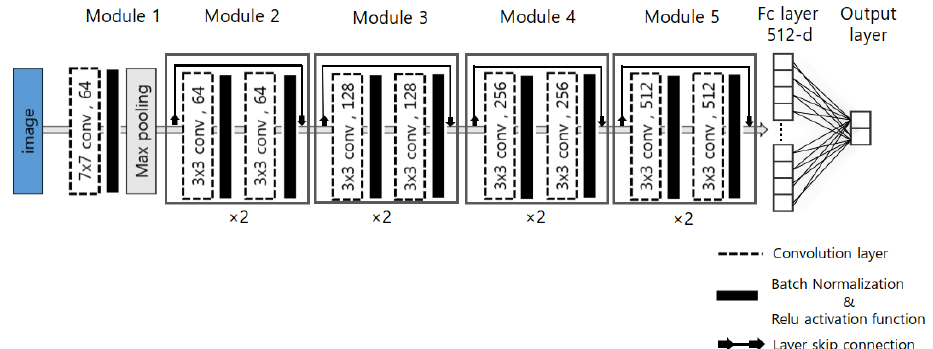
Figure 4. Configuration of ResNet consisting of five convolutional stages, which contain the convo- lution blocks comprising 7 × 7 and 3 × 3 layers. The output layer consists of as many nodes as the number of classes to be